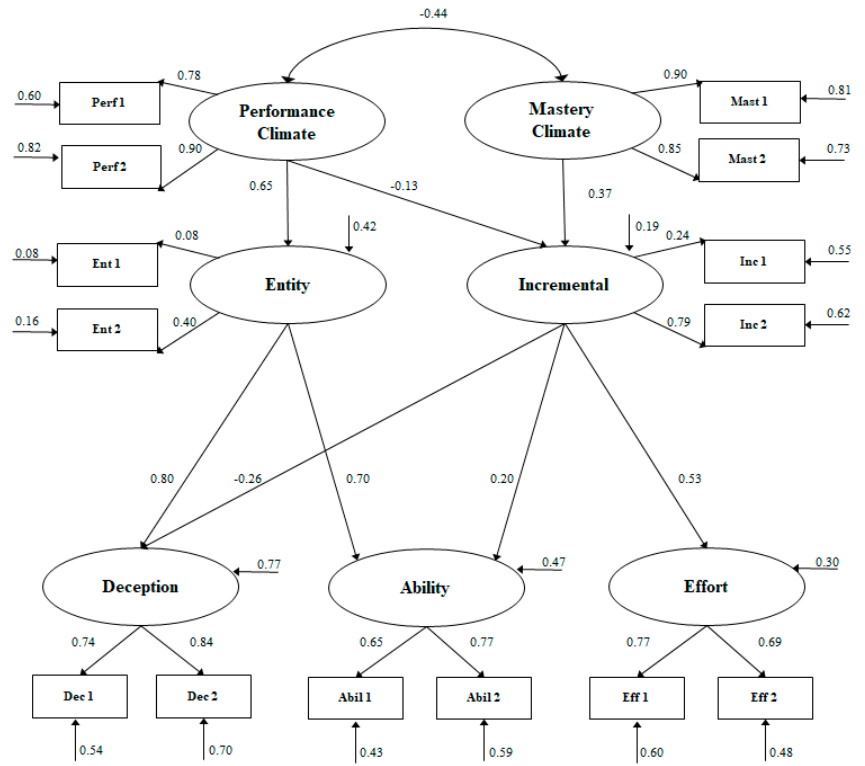
Figure 1. Structural regression model showing the relationships between the motivational climate promoted by the coach, belief in athletic ability and the beliefs about the causes of success in sports. All parameters are standardized and are statistically significant at p < 0.05. The explained variances are shown on the small arrows.